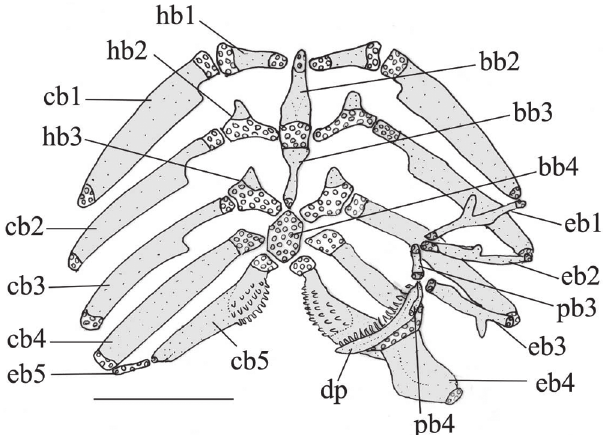
Fig. 6. Branchial skeleton of Trichomycterus payaya , MBML 2533, paratype, 31.1 mm SL. Dorsal view (right dorsal elements and gill rakers not shown). Abbreviations: bb2 to bb4, basibranchial 2 to 4; cb1 to cb5, ceratobranchials 1 to 5; dp, dentigerous plate; eb1 to eb5, epibranchials 1 to 5; hb1 to hb3, hypobranchials 1 to 3; pb3 to pb4, pharyngobranchials 3 and 4. Scale bar = 1